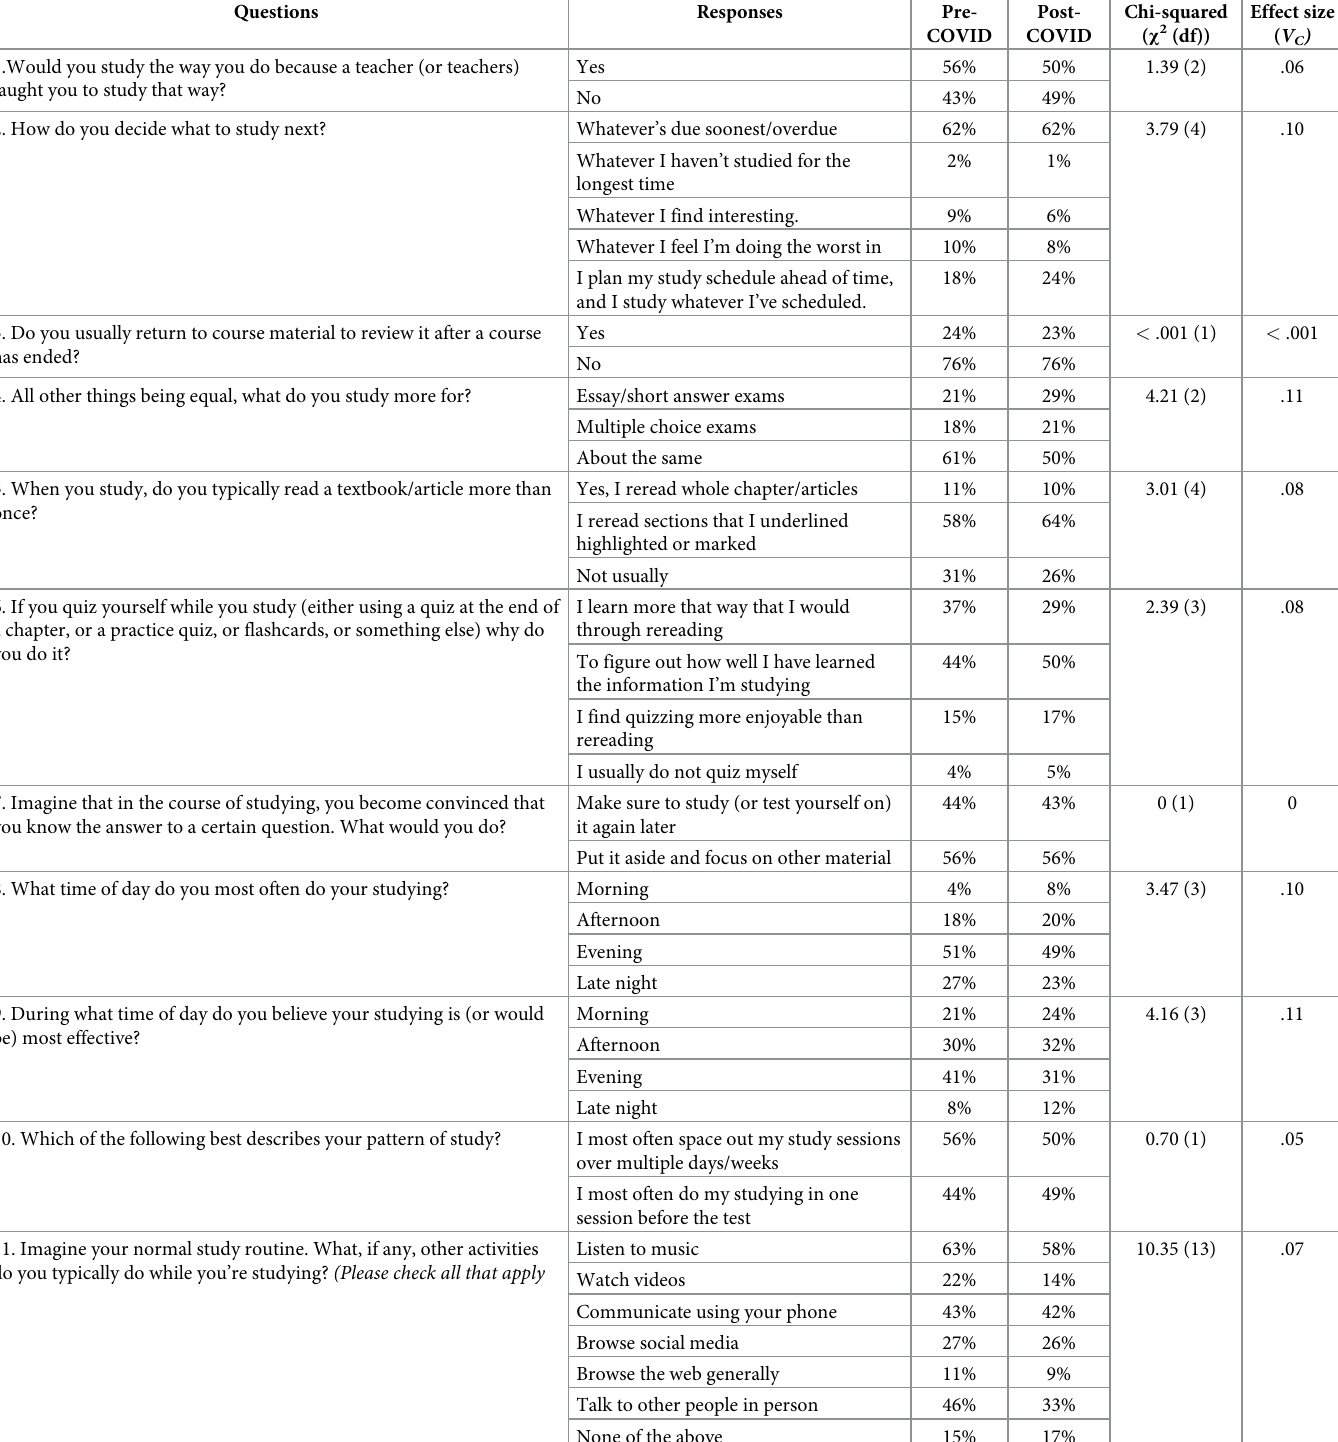
Table 3. Response percentages pre and post